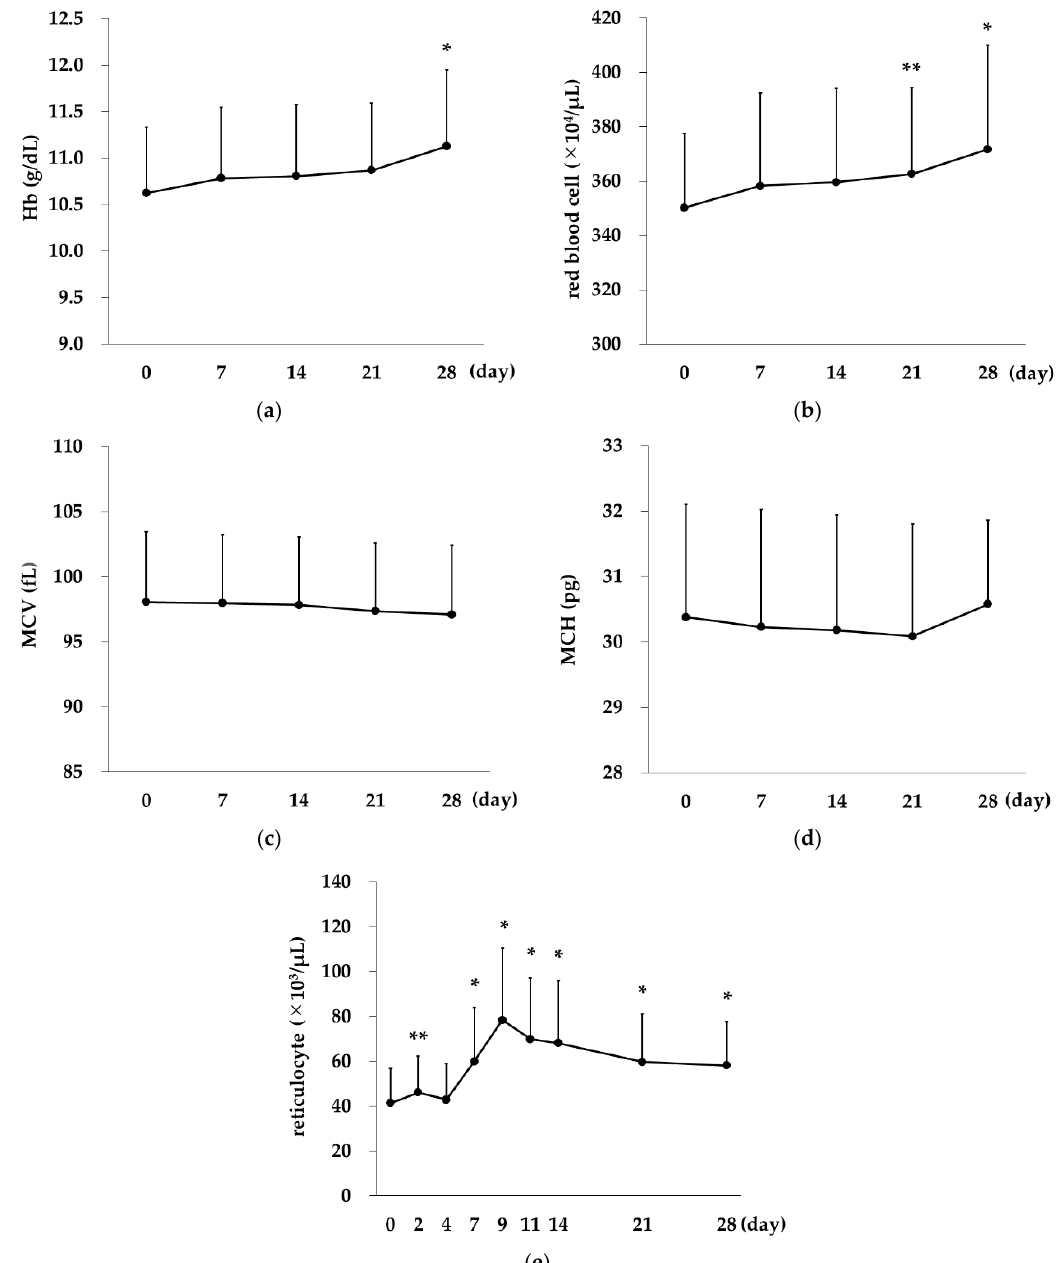
Figure 2. Changes over time in erythrocyte indices and EPO concentration in the Rox group. ( a ) Hb levels showed a significant increase on Day 28 ( p < 0.01 vs. Day 0). ( b ) RBC count showed significant increase on Day 21 ( p = 0.03 vs. Day 0) and Day 28 ( p < 0.01 vs. Day 0). ( c ) Mean corpuscular volume (MCV), ( d ) Mean corpuscular Hb (MCH), and ( e ) Ret count showed significant increases on Day 7 and all time points thereafter ( p < 0.01 on Days 7, 9, 11, 14, 21, 28 vs. Day 0). One-way repeated measures analysis of variance and Bonferrroni’s multiple comparison were performed for post-hoc tests. The data are represented as mean ± SD. * p < 0.01; ** p < 0.05.